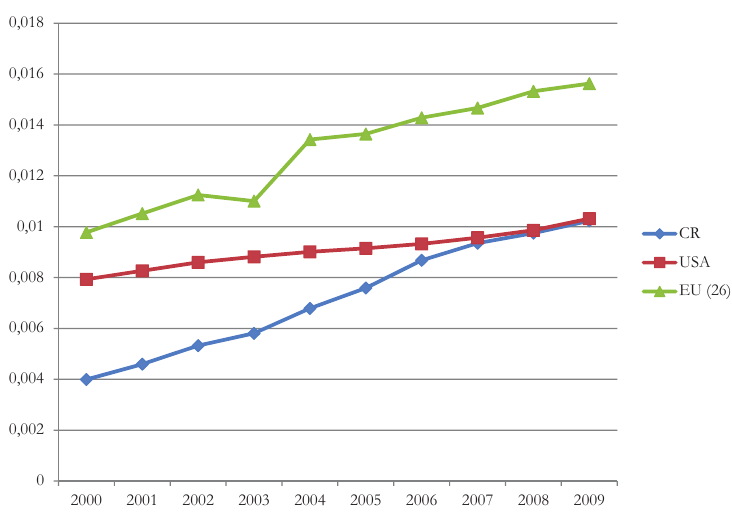
Fig. 1 - Indicator of tertiary education graduates per capita in the period 2000-2009. Source: (Eurostat, 2013a), (Worldbank, 2011), own processing.